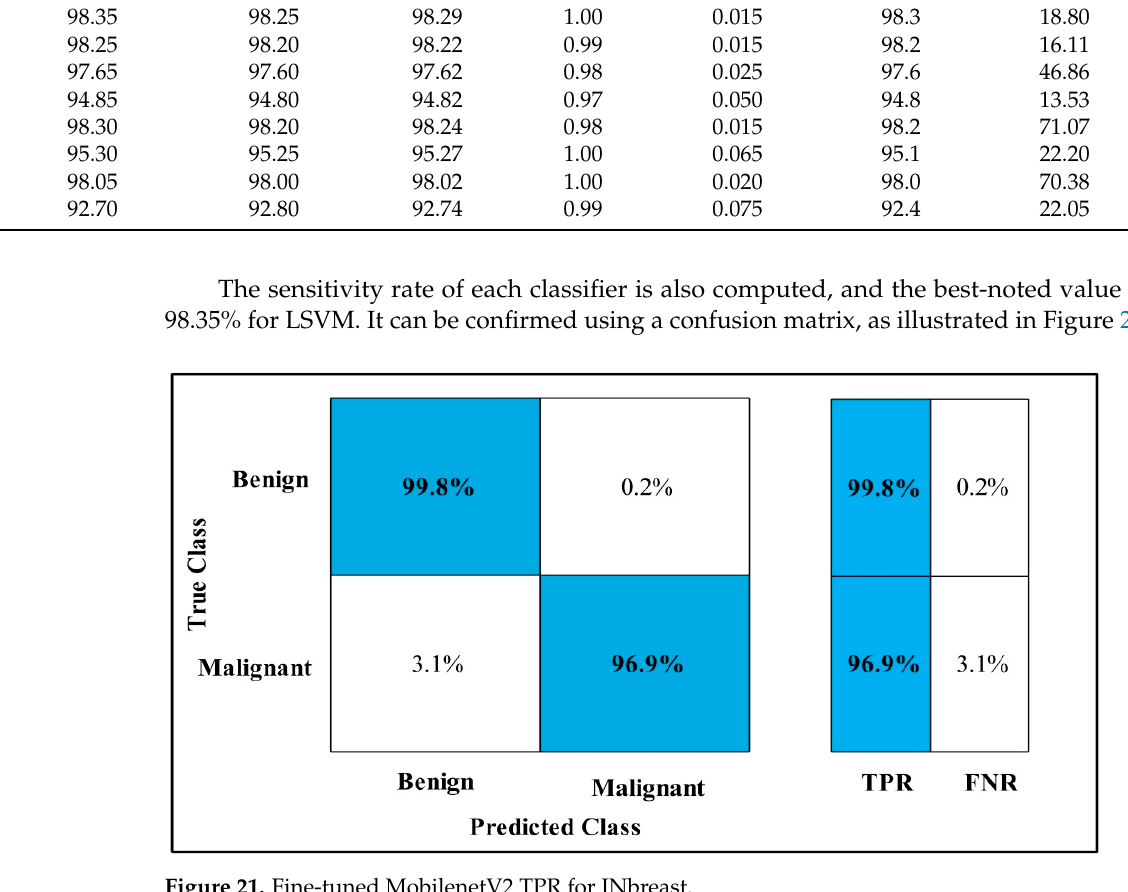
Table 14. Classification results using Fine-tuned MobilenetV2 deep features for INbreast Models